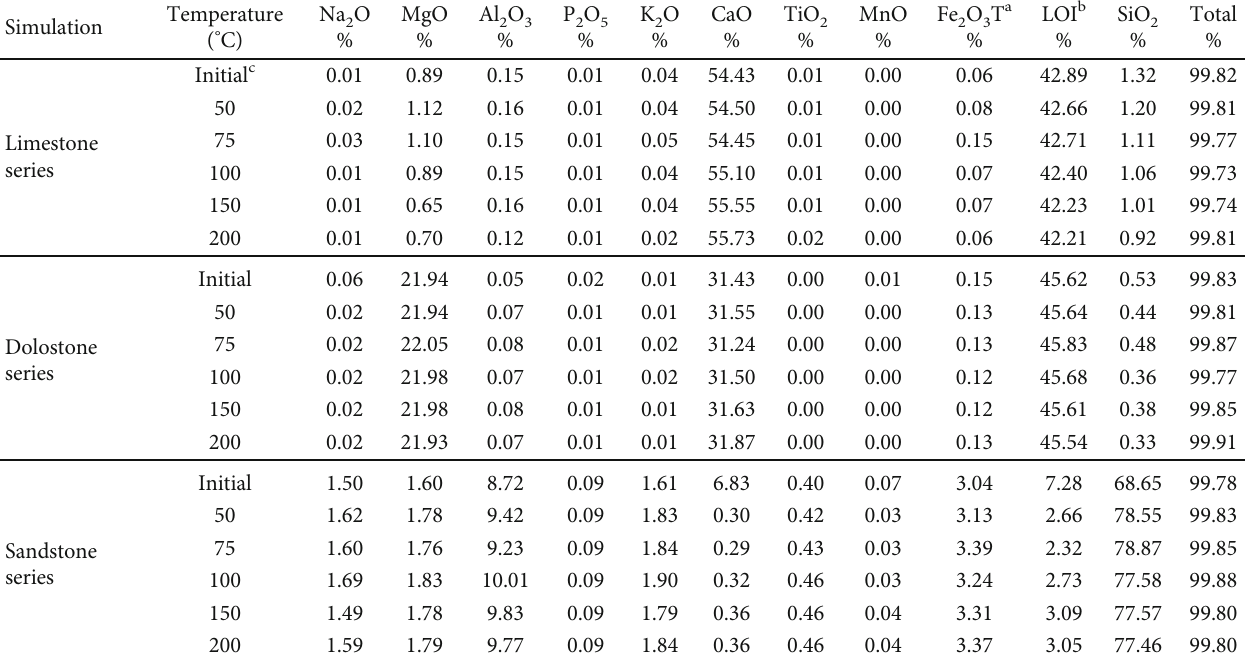
Table 3: Major element contents of initial and altered rock